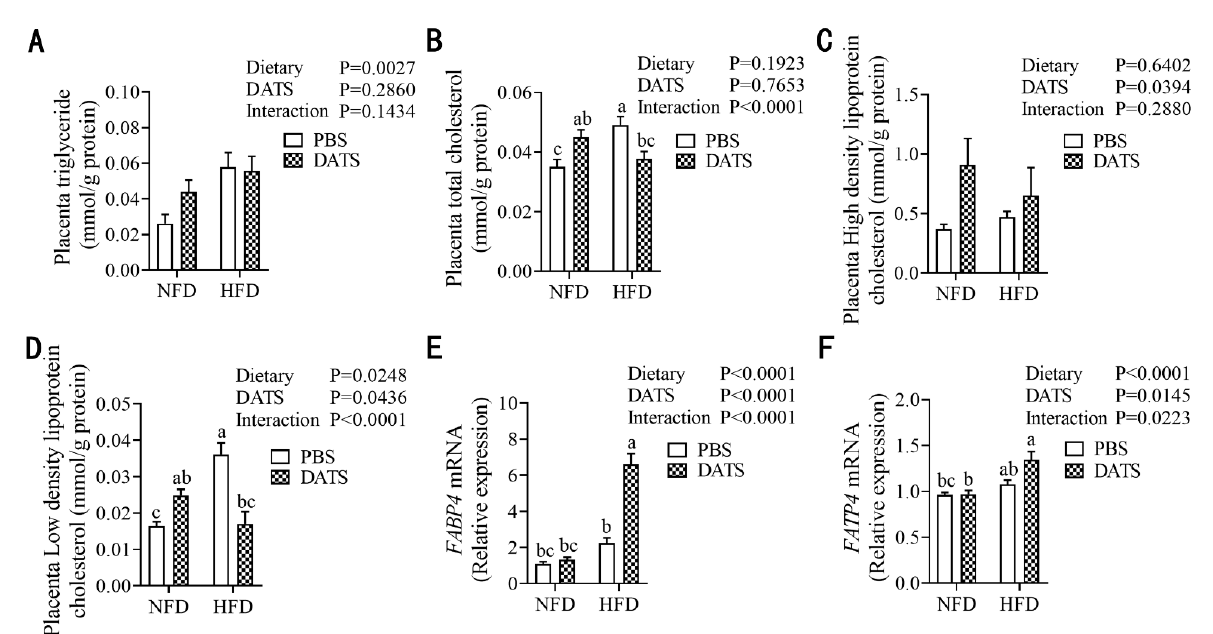
Figure 6. DATS treatment can improve the lipid metabolism of obese mice during pregnancy. ( A– D ) placental TG, TCHO, HDL-C and LDL-C levels ( n = 9–11 mice/group). ( E,F ) Relative FABP4 and FATP4 mRNA expression ( n = 9–11 mice/group). Two-way ANOVA—the values represent the mean ± SEM, p < 0.05 was considered to indicate statistical significance and different letters indicate sig- nificant differences.